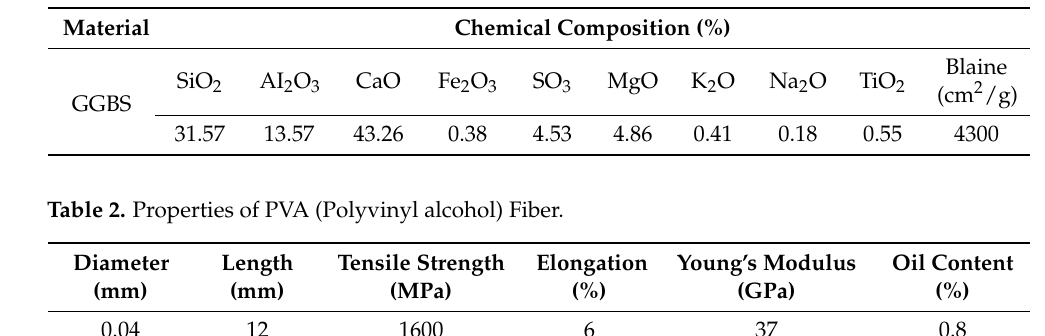
Table 1. Chemical composition of GGBS.